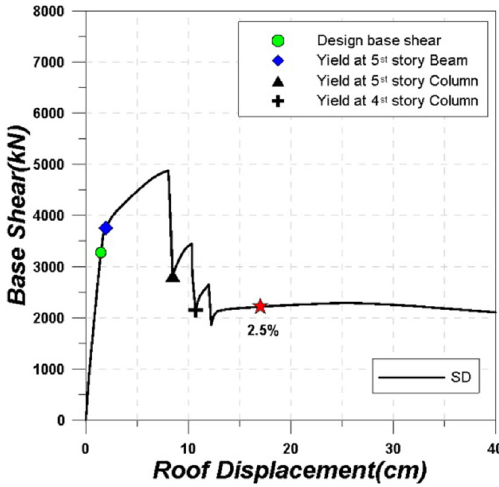
Fig. 10 Pushover curve of the strength-designed structure.